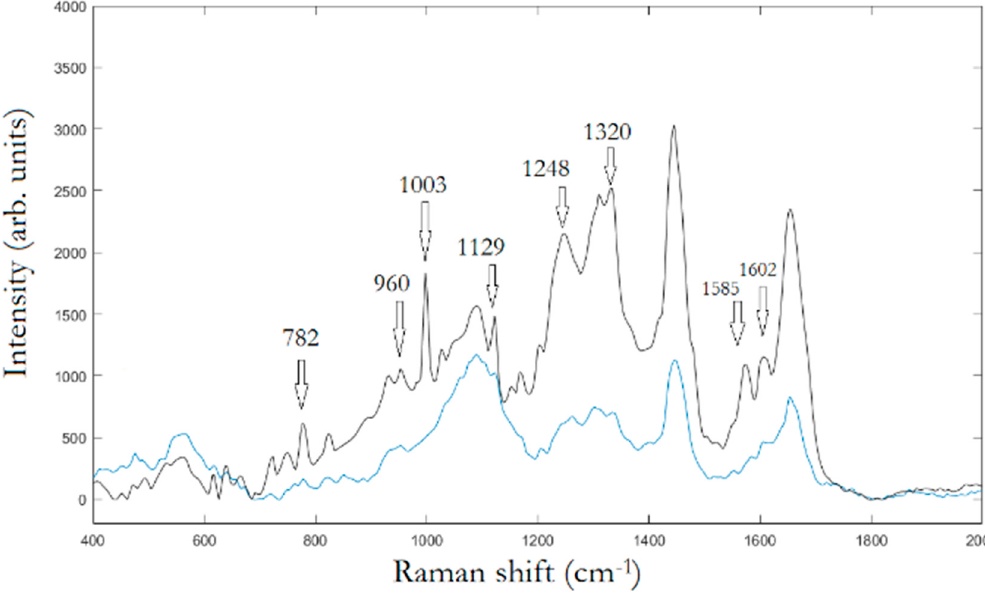
Figure 2. Averaged Raman spectra collected upon osteo-differentiated mesenchymal stem cells (MSCs) nucleus, blue line, and correspondent spectra collected upon MG-63 nucleus, black line.